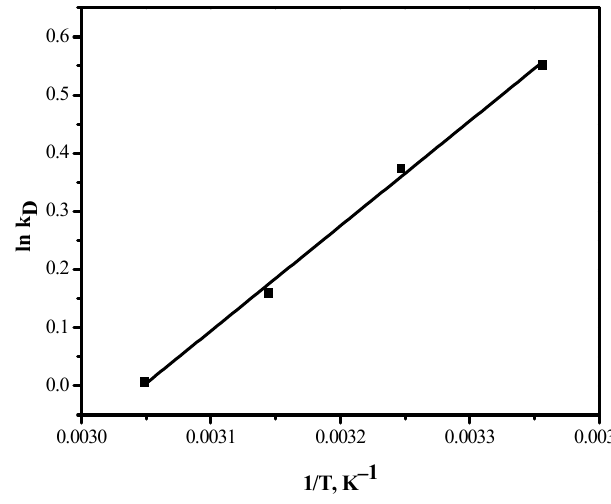
Figure 13. Plot of ln k D against 1/T. Table 3. Thermodynamic parameters of the adsorption of Pb(II) ions on the GA/MNP